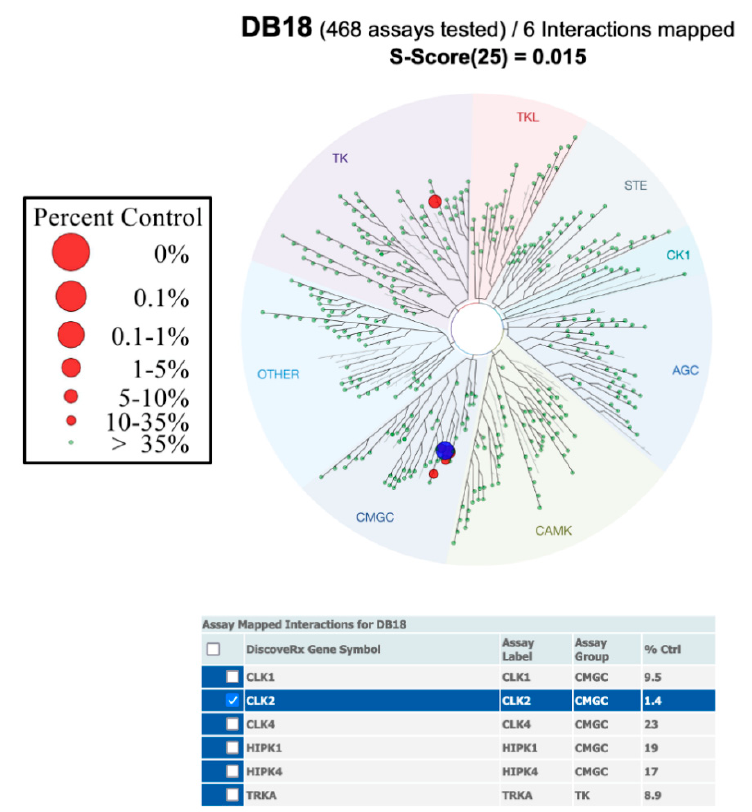
Figure 6. DB18 is a highly selective inhibitor of